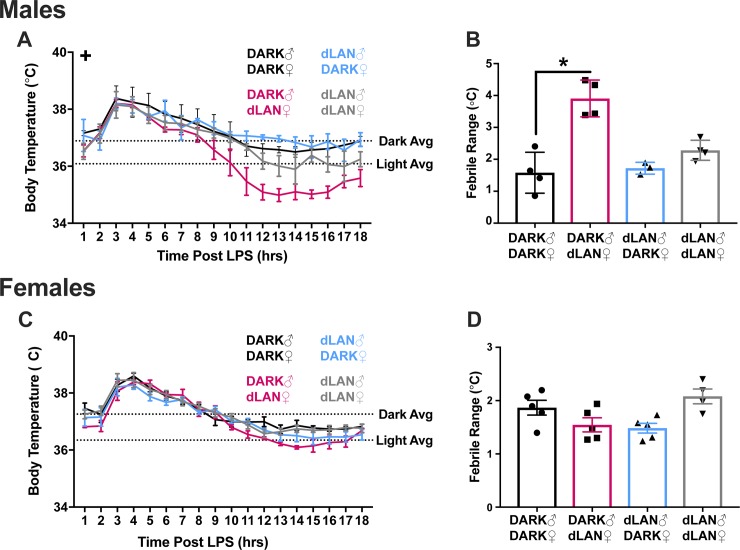
Male offspring of dams exposed to preconception dLAN enhanced magnitude of febrile responses.Body temperature from 0 to 18 hours post-LPS and febrile range in male (A,B) and female (C,D) offspring. Horizontal dashed lines represent mean baseline body temperature during the dark and light phase. N = 3-5/group/sex; error bars represent SEM. +, P < 0.05 Dark-dLAN vs Dark-Dark and dLAN-dLAN; *, P < 0.05 Dark-dLAN vs Dark-Dark.